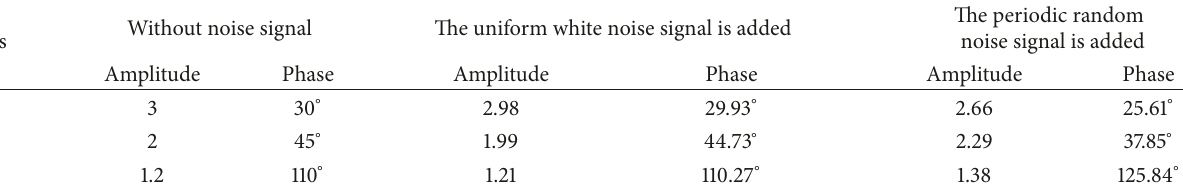
Table 1: The amplitudes and phases of the first 3-order frequency component fitted by least square method. Without noise signal The uniform white noise signal is added Orders